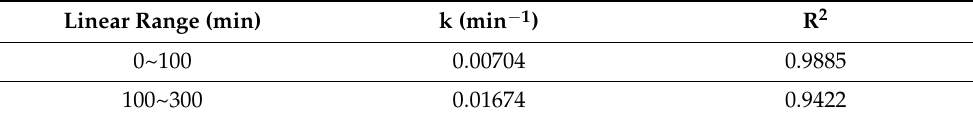
Table 2. Linear relationships of In ( C 0 / C ) vs. t based on pseudo-first-order model.